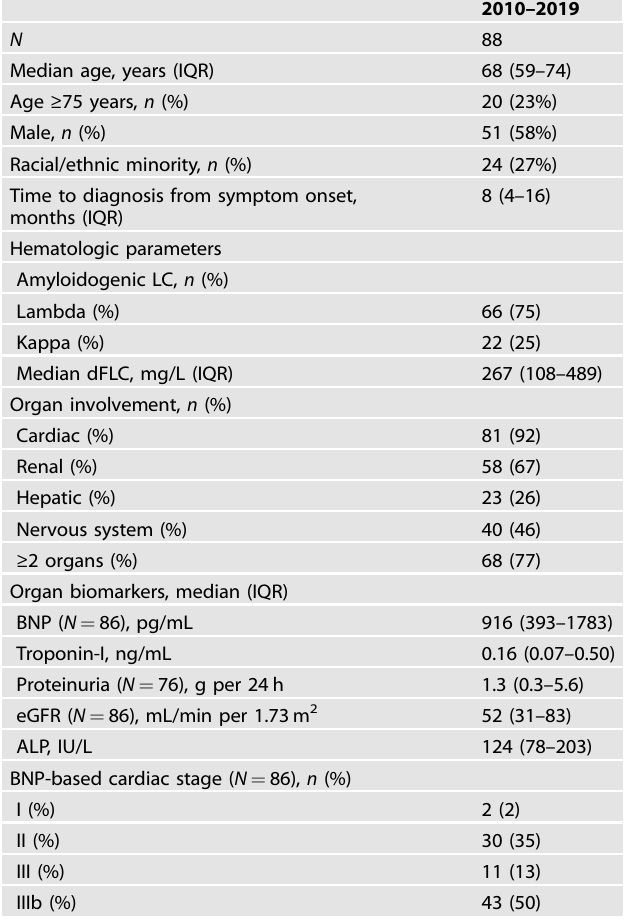
Table 4. Characteristics of patients from the latest era who experienced early